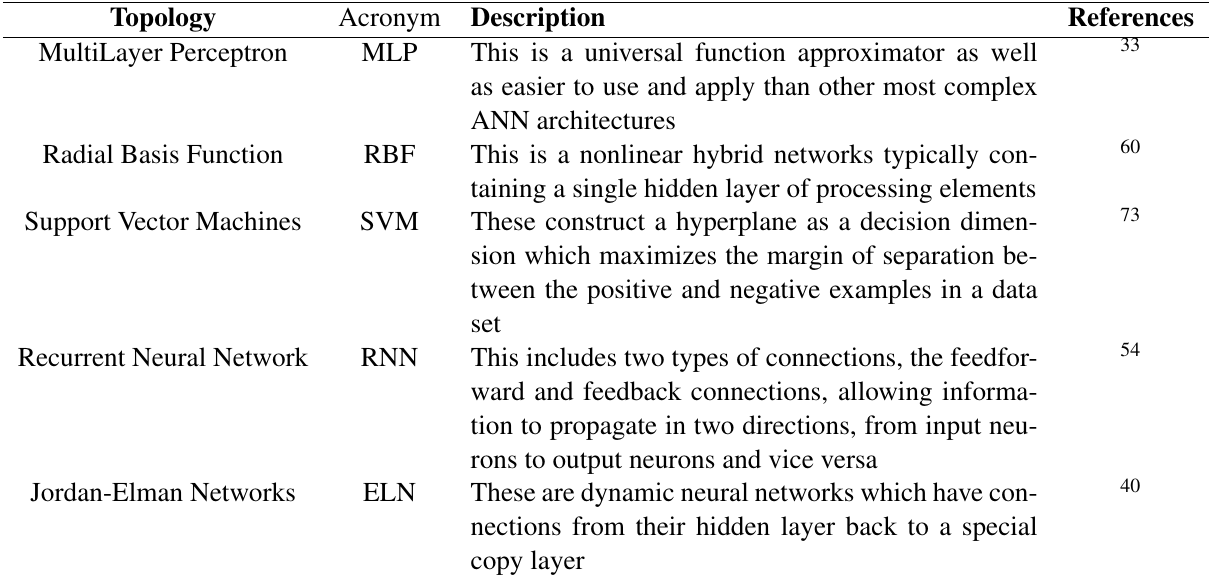
Table 3: Stage 1. ANN